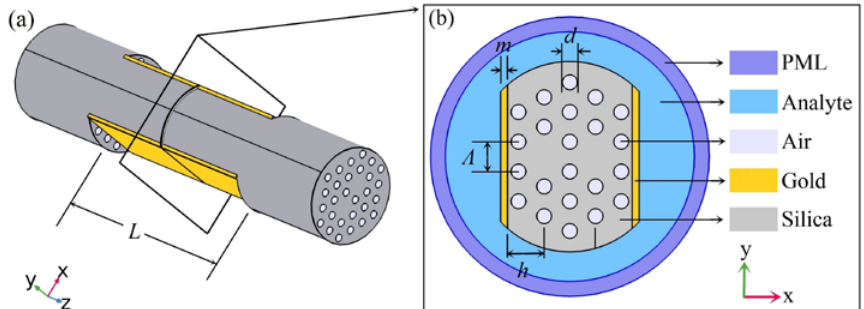
Figure 1. ( a ) Schematic diagram of the proposed dual-side polished microstructured optical fiber (MOF)-based surface plasmon resonance (SPR) sensor with a dual core; ( b ) cross-section of the proposed MOF-based SPR sensor.